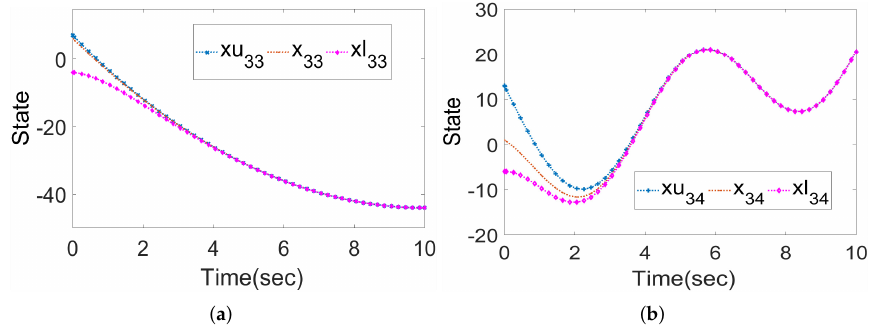
Figure 3. Evolutions of velocity of original system and DIO at the first joint ( a ) and second joint ( b ) of third manipulator.